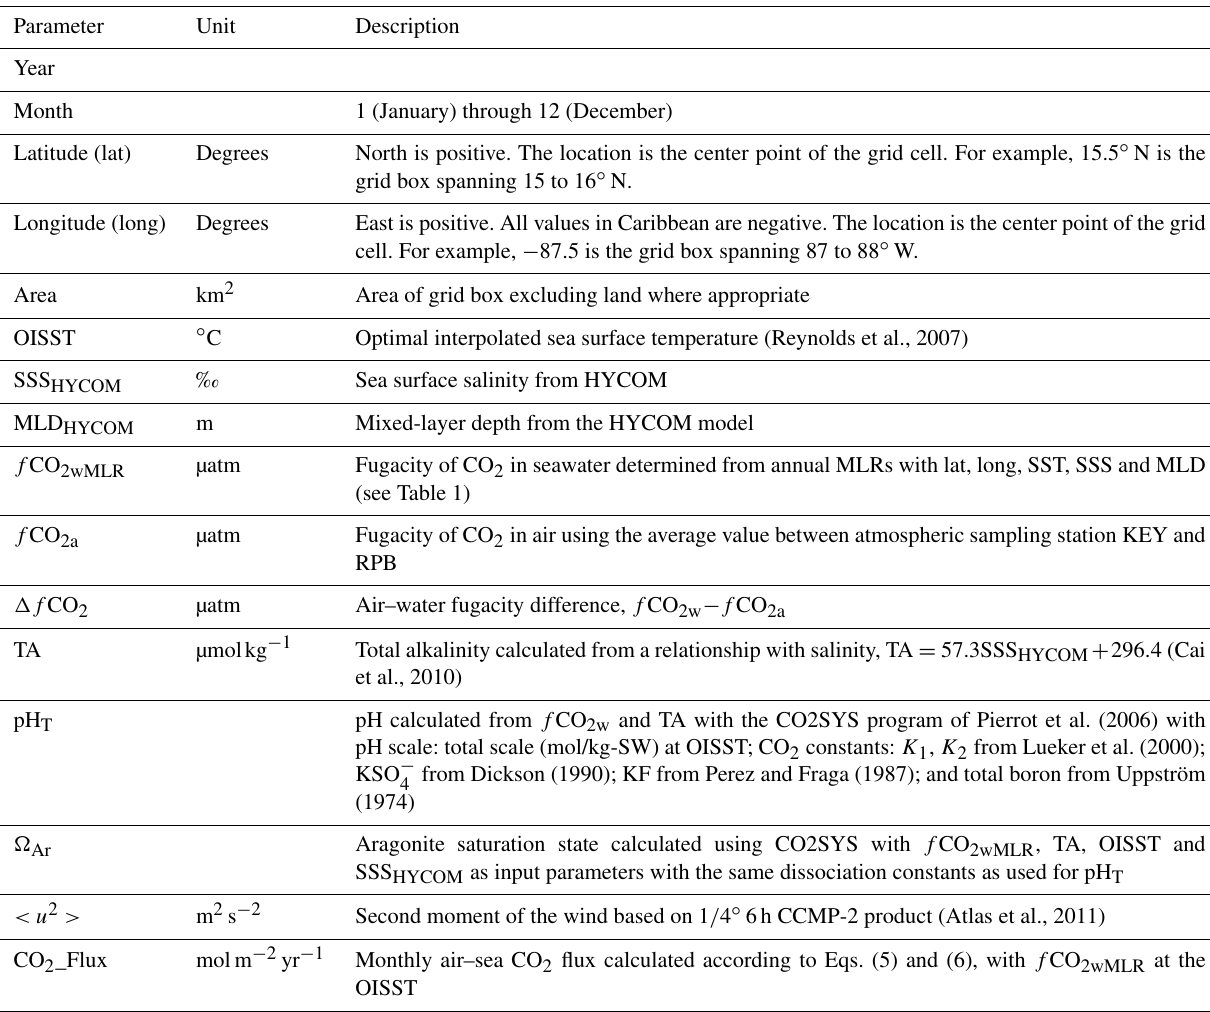
Table 4. Column headers, units and description for the monthly 1 ◦ mapped product (1 ◦ by 1 ◦ by month) for the whole region. Parameter Unit